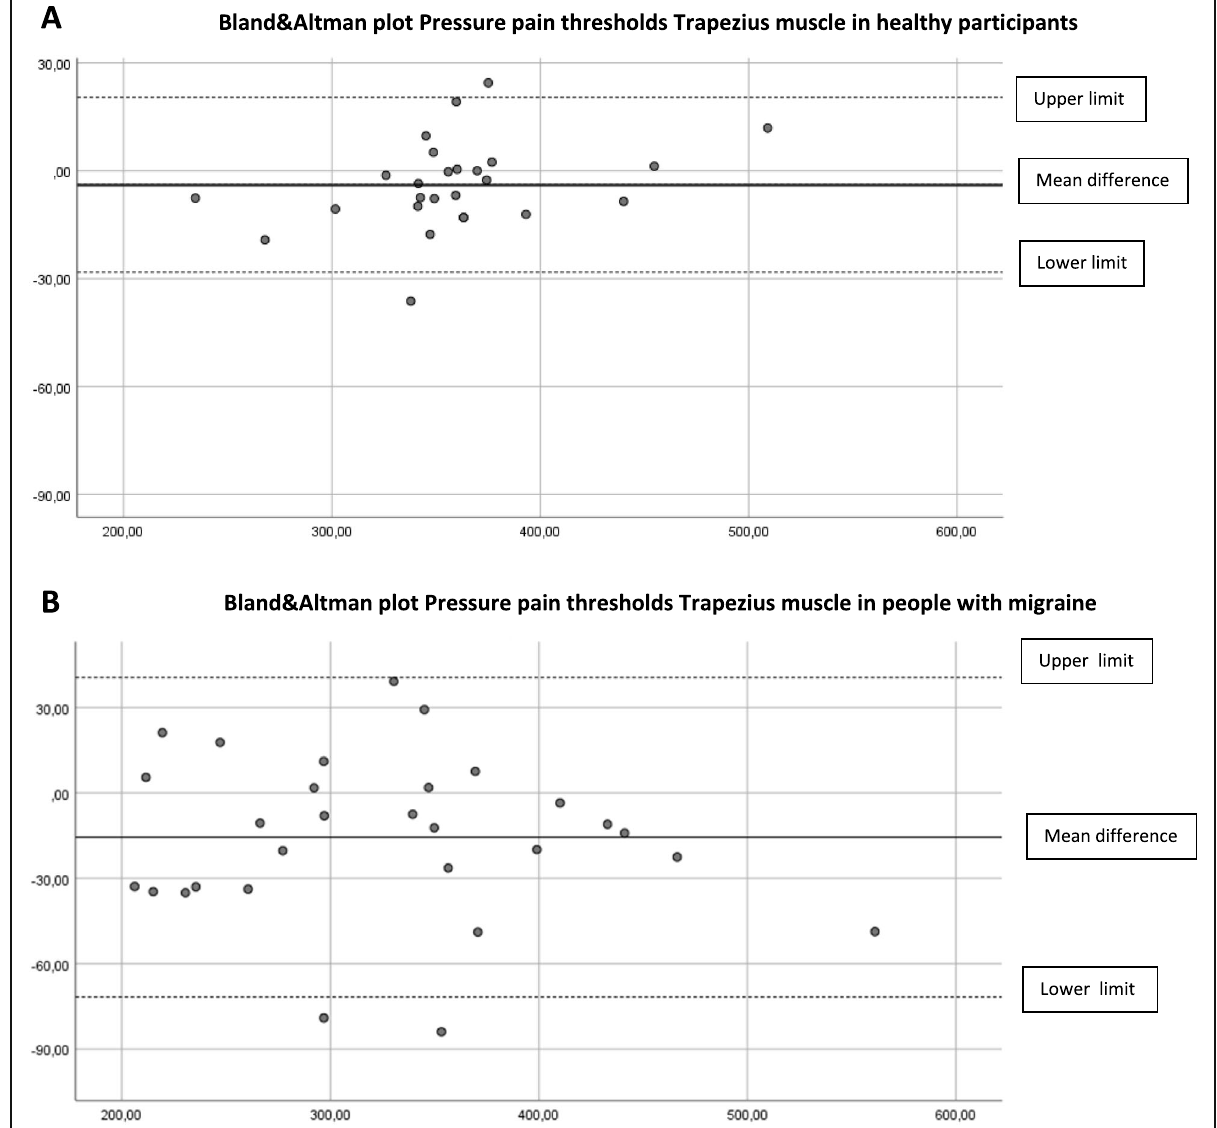
Fig. 4 A Differences Pressure Pain Thresholds digital and analogue algometer Trapezius muscle dominant side in healthy participants (mean difference, upper and lower limit). B Differences Pressure Pain Thresholds digital and analogue algometer Trapezius muscle dominant side in people with migraine (mean difference, upper and lower